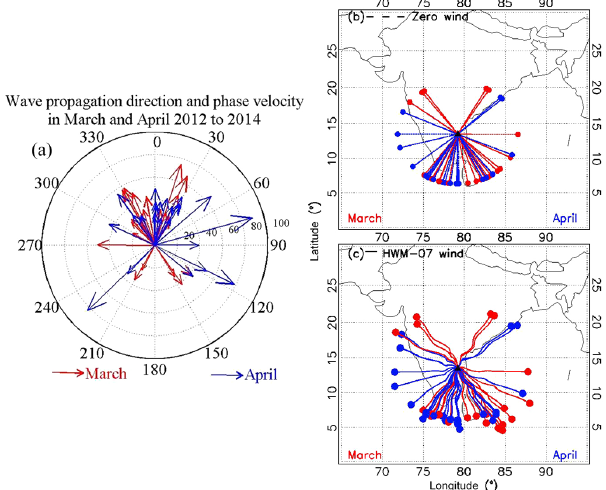
Figure 5. (a) shows the observed phase speed and direction of hor- izontal propagation of gravity waves, and Fig. 5b and c denote the reverse-ray-tracing results in (b) zero wind as well as in (c) HWM- 07 model wind condition in March–April 2012 and 2014 and April 2013. The red-colored arrows (lines) indicate March events, while blue arrows (lines) show the events noted in April. In the polar plot the inner dotted circles indicate the horizontal phase speed of the observed wave at an interval of 20ms − 1 . In right-side plots red (blue) dots indicate the source origin in March